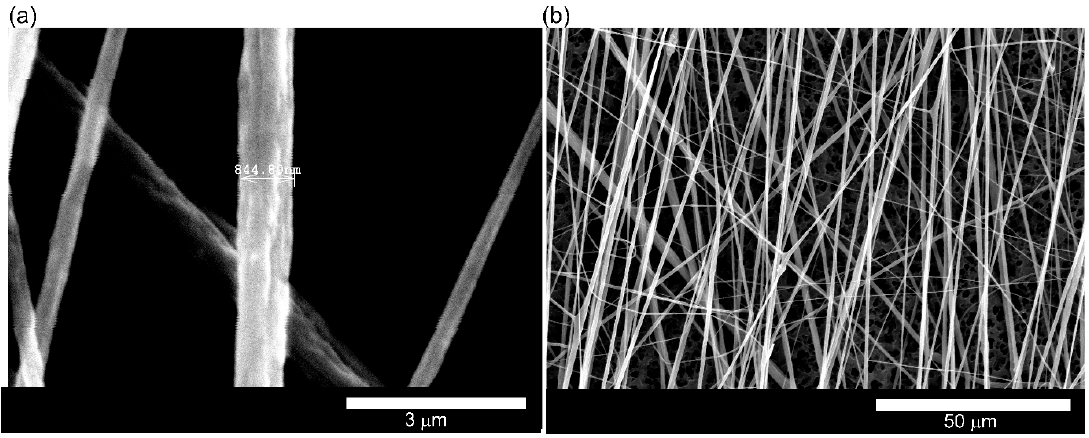
Figure 1. scanning electron microscope (SEM) images of PVDF electrospun nano fibers (a) single nano fiber (b) aligned fiber bundle.